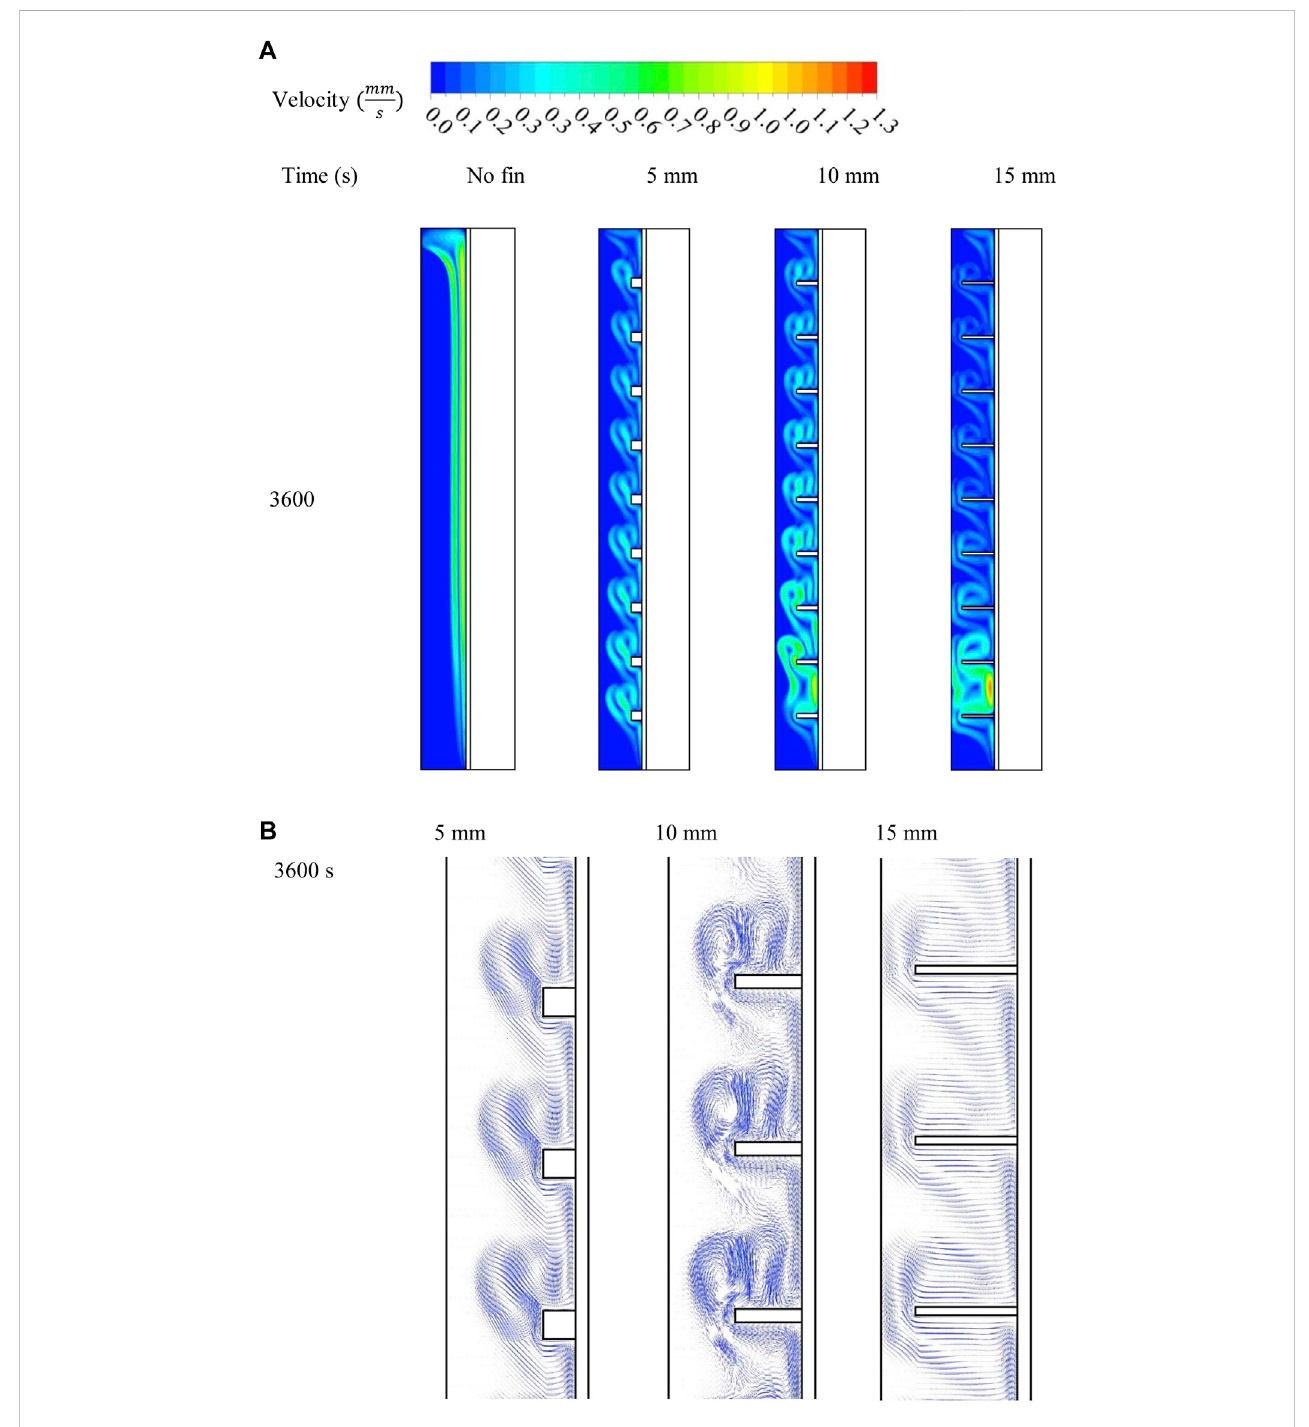
FIGURE 6 Velocity contour (A) and stream factor (B) of the liquid phase of the PCM for various fi n lengths at different time